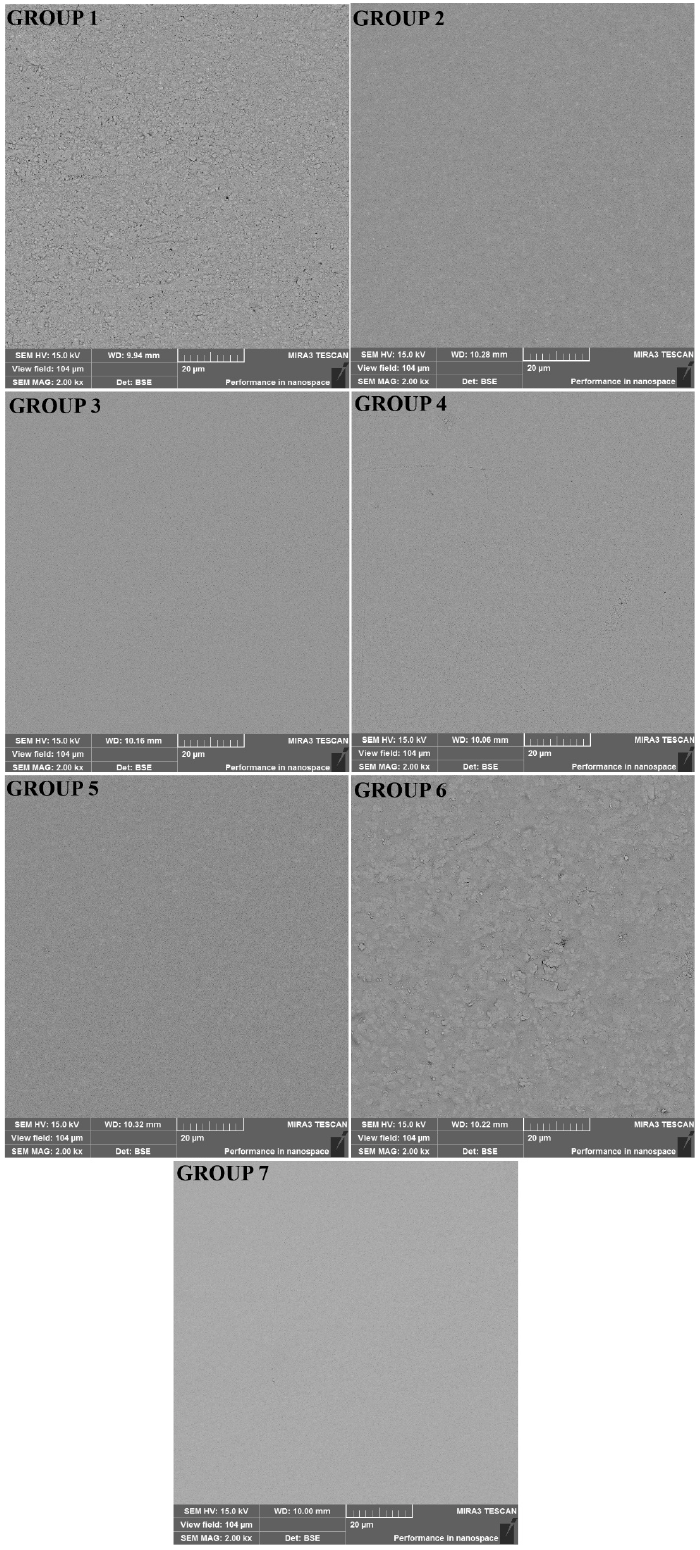
Figure 1. The SEM photographs obtained at 2000 × magnification from the surfaces of the dental restorative materials. Group 1 (LC-Cent), Group 2 (SC-Cent), Group 3 (COMP), Group 4 (DYRA), Group 5 (LINER), Group 6 (FUJI), and Group 7